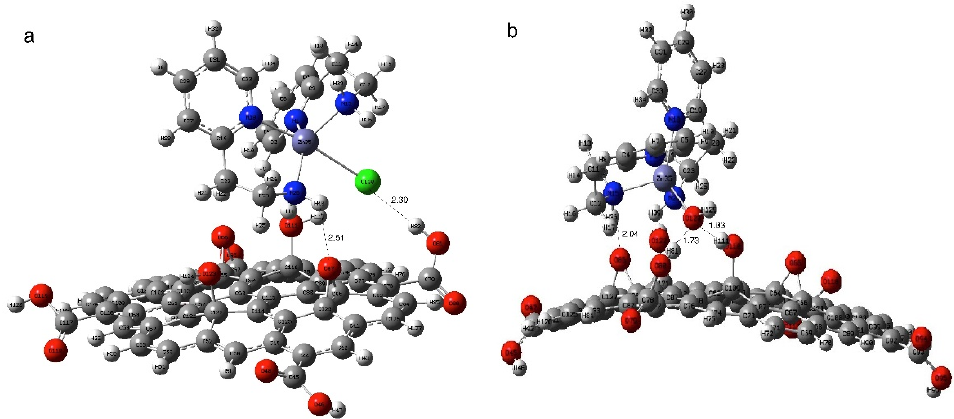
11 of 23 Figure 8. ( a ) optimized structure of Zn3 , ( b ) optimized structure of GO, ( c ) the MESP map and ( d ) the HOMO orbitals of GO nanosheet calculated at B3LYP/6– 311++G(d,p) level of theory. A total of 110 carbon atoms and various oxygen surface groups, such as two epoxy groups, two hydroxy groups and four terminal carboxylic groups, were simulated on the GO sheet. The selected GO sheet has been widely used for the adsorption of organic and inorganic surface molecules [56,57]. The optimized GO structure along with the measured MESP map is shown in Figure 8b. The MESP demonstrates the existence of nucleophilic sites that could be potential atoms for binding to the Zn3 complex of zinc(II), while the measured GO HOMO orbitals display the contribution of the epoxy and hydroxyl groups to the surface binding group. The optimized structures of Zn1 /GO and Zn3 /GO are shown in Figure 9. Data of Zn1 /GO show that the complex is stabilized by various hydrogen bonds such as Cl38... H82-O81 (2.30 Å), O87... H41-N26 (2.51 Å), with a bond angle of 175 and 165 ◦ , respectively. The formed hydrogen bonds’ lengths in Zn3 /GO were shorter than Zn1 /GO, for example, O128 . . . H111-O118 (1.83 Å), O128 . . . H81-O88 (1.73 Å) and O85 . . . H36-N15 (2.04 Å), with bond angles of 179, 165 and 171 ◦ respectively. The adsorption energies calculated for Zn1 /GO and Zn3 /GO were − 9.2 and − 14.3 kcal/mol, respectively, confirming the high stability and exothermic adsorption of Zn3 /GO. In addition, the high exothermic adsorption energy of Zn3 /GO was confirmed by the calculated ∆ H = − 6.4 kcal/mol compared to Zn1 /GO ( ∆ H = − 1.2 kcal/mol).